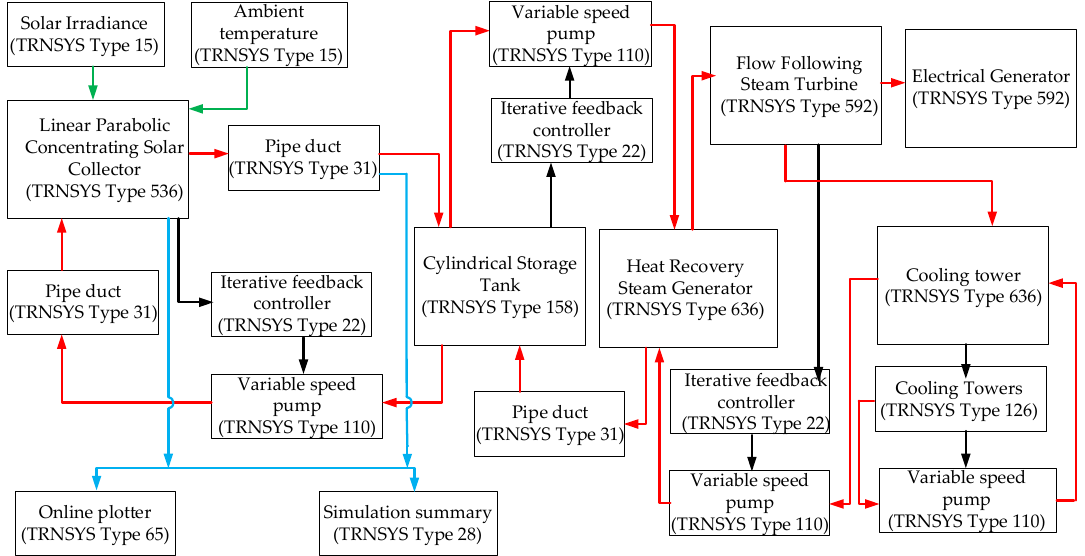
Figure 6. Model of the distributed collector system.